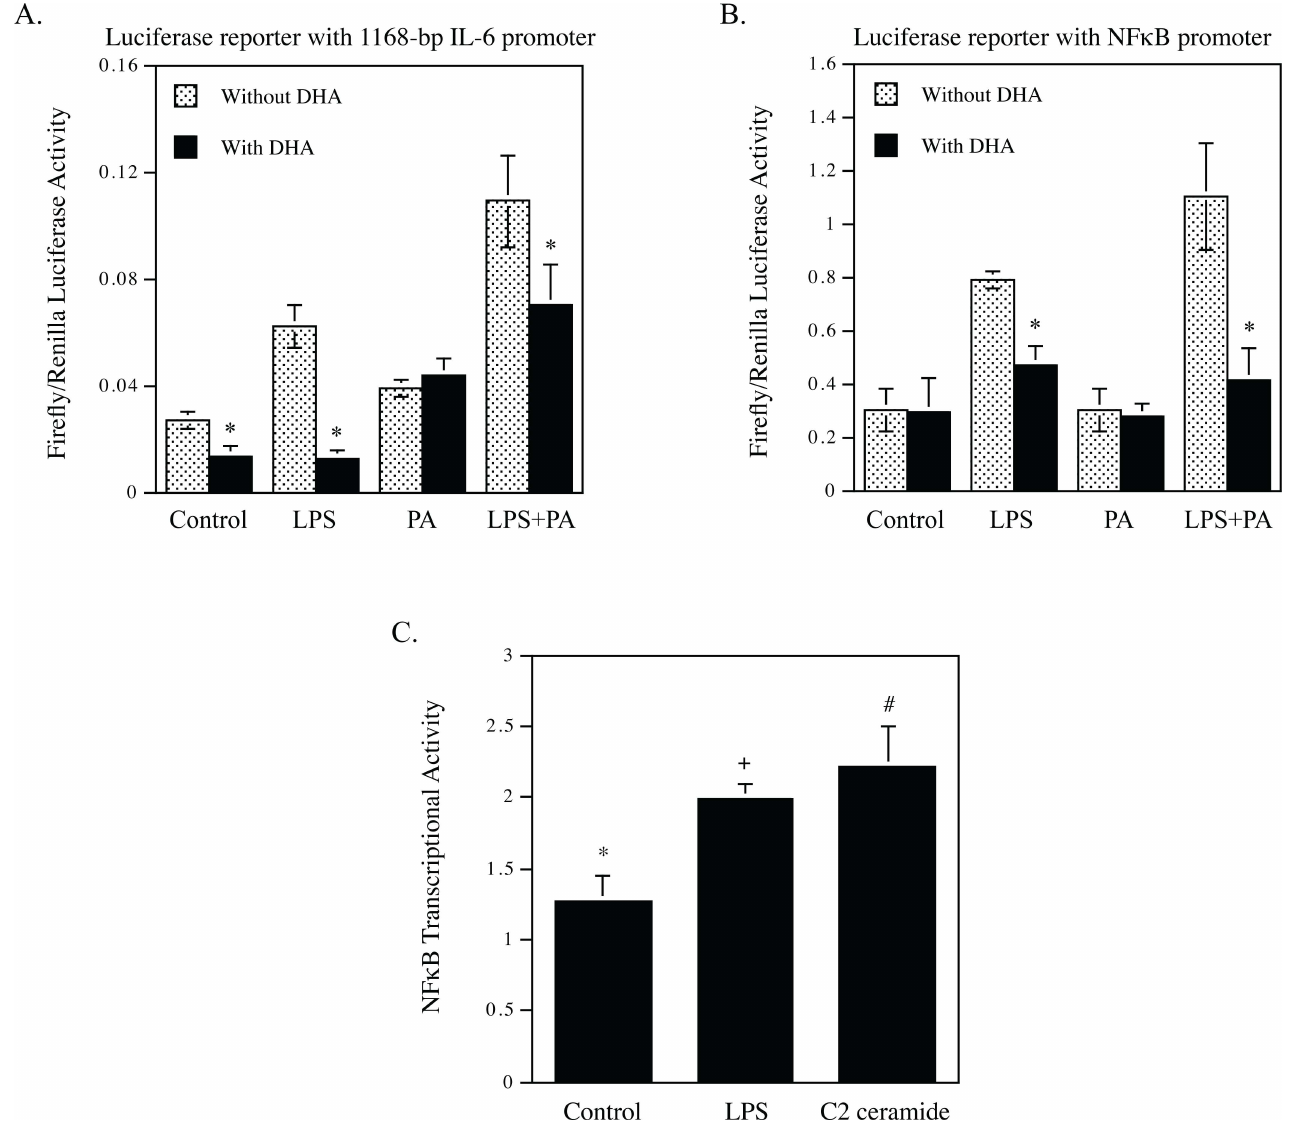
Fig 4. DHA inhibits IL-6 transcription and NF κ Btranscriptional activity. A. RAW264.7 macrophages were transfected with plasmids containing an 1168-bp IL-6 promoter sequence and luciferase reporter gene for 24 h. After the transfection, the macrophages were treated with 1 ng/ml of LPS, 100 μM of PA or both LPS and PA for 24 h and cellular firefly and renilla luciferase activities were assayed. The ratios of firefly vs. renilla luciferase were calculated. (cid:3) vs. cells with the same treatment in the absence of DHA, p < 0.01. B. RAW264.7 macrophages were transfected with DNA construct containing the tandem repeats of NF κ B transcriptional response element in the promoter and luciferase reporter gene for 24 h. After the transfection, the macrophages were treated with 1 ng/ml of LPS, 100 μM of PA or both LPS and PA for 24 h and cellular firefly and renilla luciferase activities were assayed. The ratios of firefly vs. renilla luciferase were calculated. The ratios of firefly vs. renilla luciferase activity were calculated. (cid:3) vs. cells with the same treatment in the absence of DHA, p < 0.01. C. RAW264.7 macrophages were transfected with DNA construct containing the tandem repeats of NF κ B transcriptional response element in the promoter and luciferase reporter gene for 24 h. After the transfection, the macrophages were treated with 1 ng/ml of LPS or 50 μM of C2-CER for 24 h and cellular firefly and renilla luciferase activities were then assayed. The ratios of firefly vs. renilla luciferase activity were calculated. (cid:3) vs. +, p < 0.05; (cid:3) vs. #, p < 0.05.